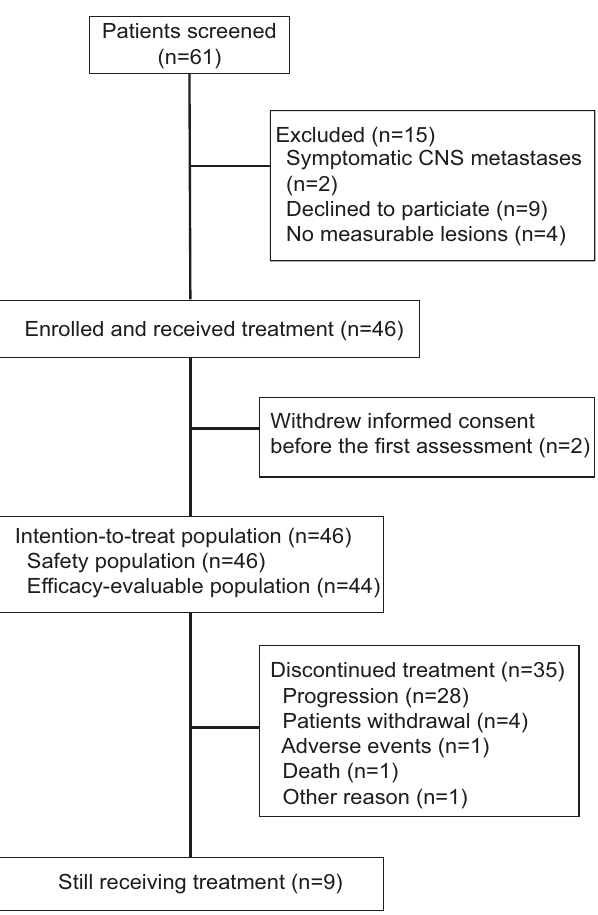
Fig. 1 Trial pro fi le. Treatment summary and data collection of study participants. Participants were recruited from 3 hospital sites in